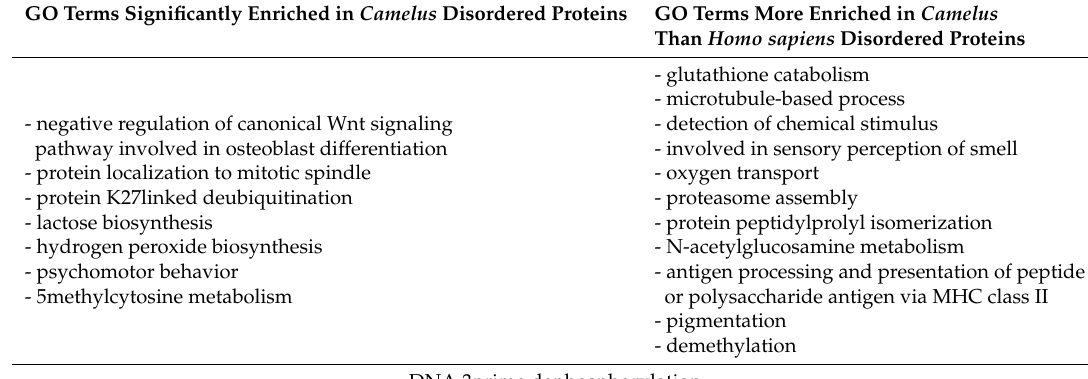
Table 2. Representative functional terms enriched in disordered Camelus proteins and those more enriched in Camelus relative to Homo sapiens